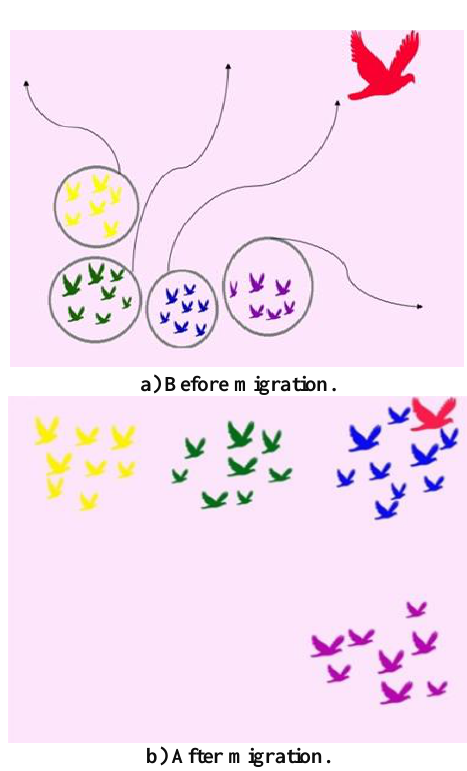
Figure 4. Migration in extended cuckoo algorithm.